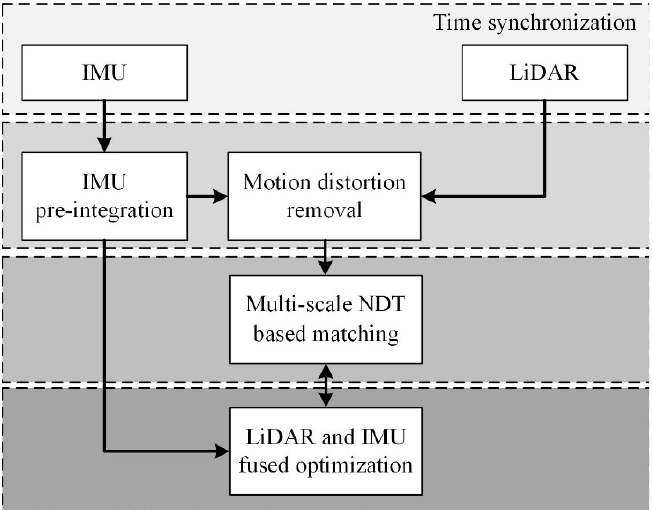
Figure 3 Workflow of multi-scale NDT based LIDAR-IMU